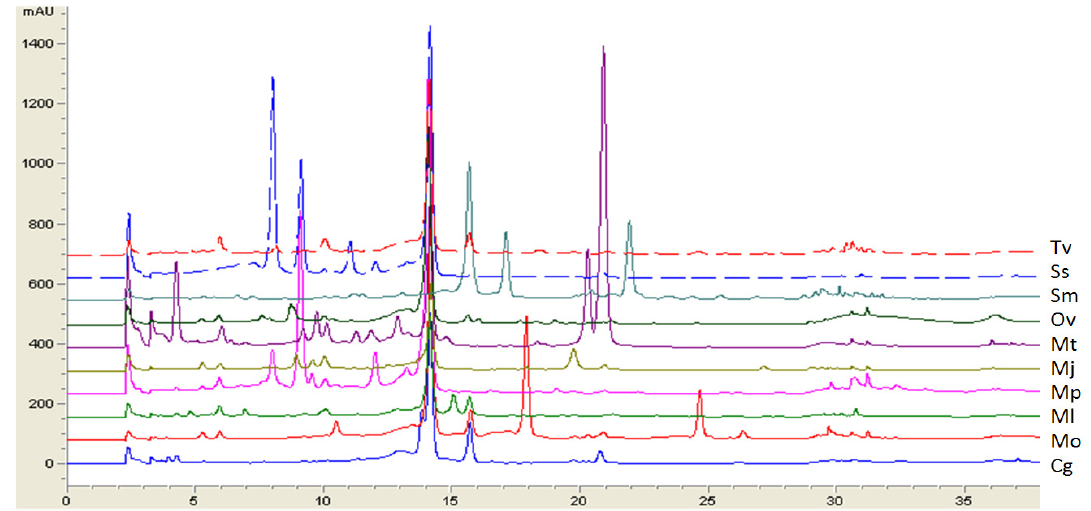
Figure 2. Overlay of HPLC-DAD chromatograms at 330 nm of the ethanolic extracts of Lamiaceae medicinal plants rich in rosmarinic acid (Rt = 14.1